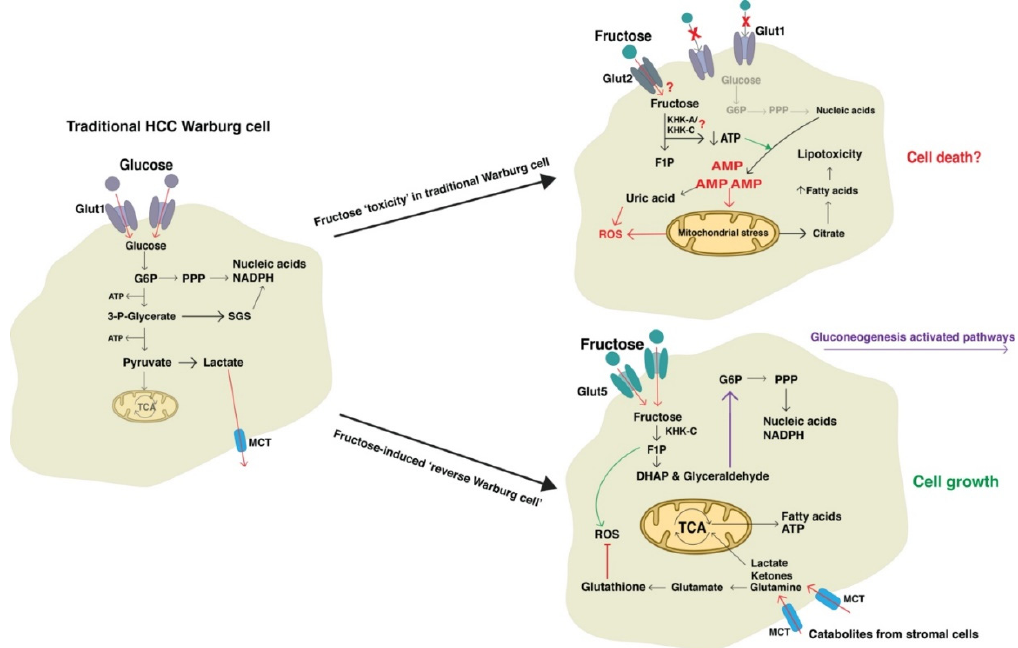
Figure 3. Potential consequences of fructose metabolism in hepatocellular carcinoma (HCC) . A traditional HCC cancer cell may exhibit the Warburg effect where glycolysis is favored to produce ATP and glycolytic products for nucleotide synthesis. If this cancer cell is exposed to fructose as the only source of fuel, the toxic effects of fructose may be deleterious to the cell by depleting energy and increasing ROS, leading to cell death. However, in cancer cells exposed to high concentrations of fructose, the cancer cell may metabolically adapt to sustain growth (Table 1). P, fructose-1-phosphate; G6P, glucose-6-phosphate; Glut1, glucose transporter 1; Glut2, glucose transporter 2; Glut5, glucose transporter 5; KHK-A, ketohexokinase-A; KHK-C, ketohexokinase-C; MCT, monocarboxylate transporters; PPP, pentose phosphate pathway; ROS, reactive oxygen species; SGS, serine to glycine synthesis pathway; TCA, tricarboxylic acid cycle (citric acid cycle).